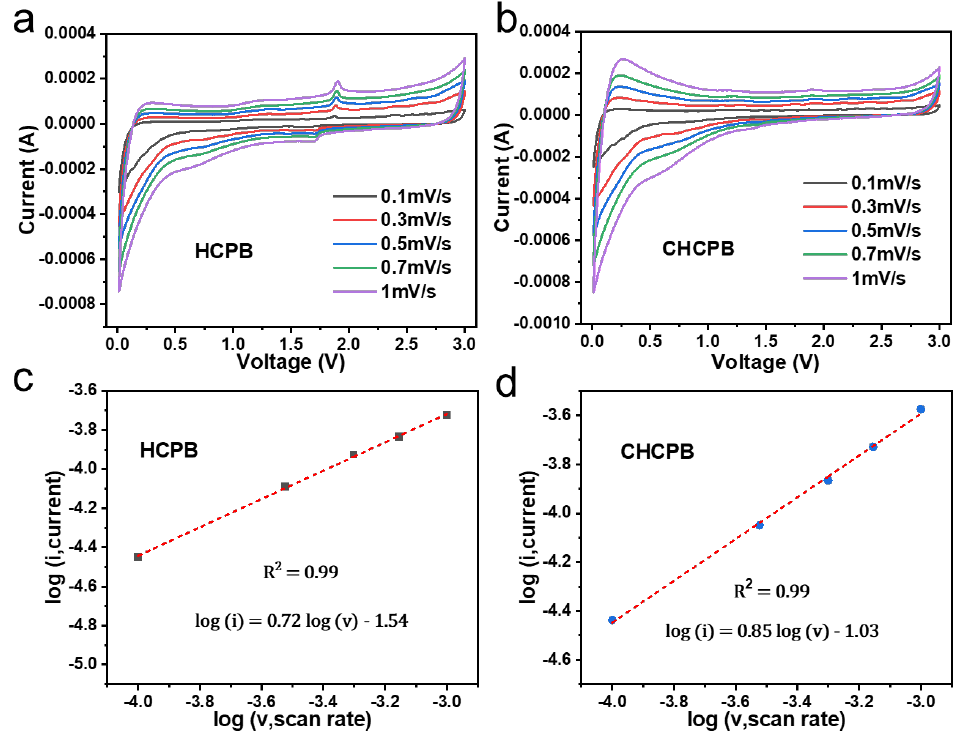
Figure 5. ( a , b ) CV curves of HCPB and CHCPB with scan rates from 0.1 to 1.0 mV s –1 ; ( c , d ) log ( i )-log ( b ) graphs of HCPB and CHCPB.